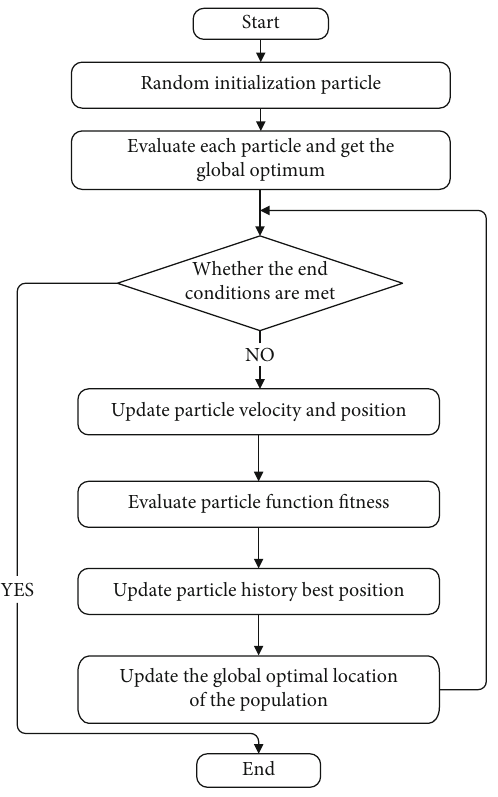
Figure 14: Flow diagram of particle swarm optimization